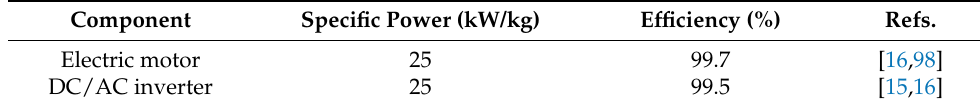
Table A3. Specifications for the electric components in the all-electric aircraft